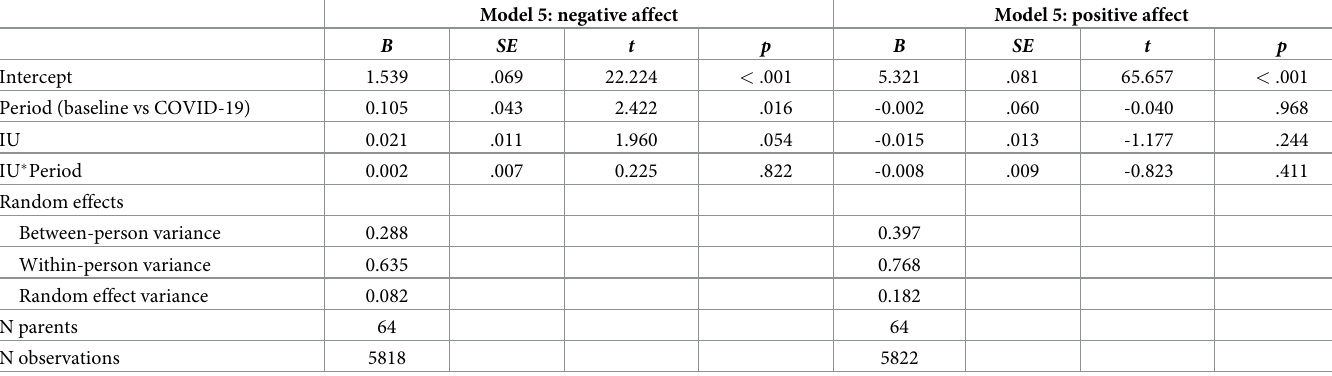
Table 2. Results of final model 5 on the relation between period and affect and the moderating role of intolerance of uncertainty in parents. Model 5: negative affect Model 5: positive